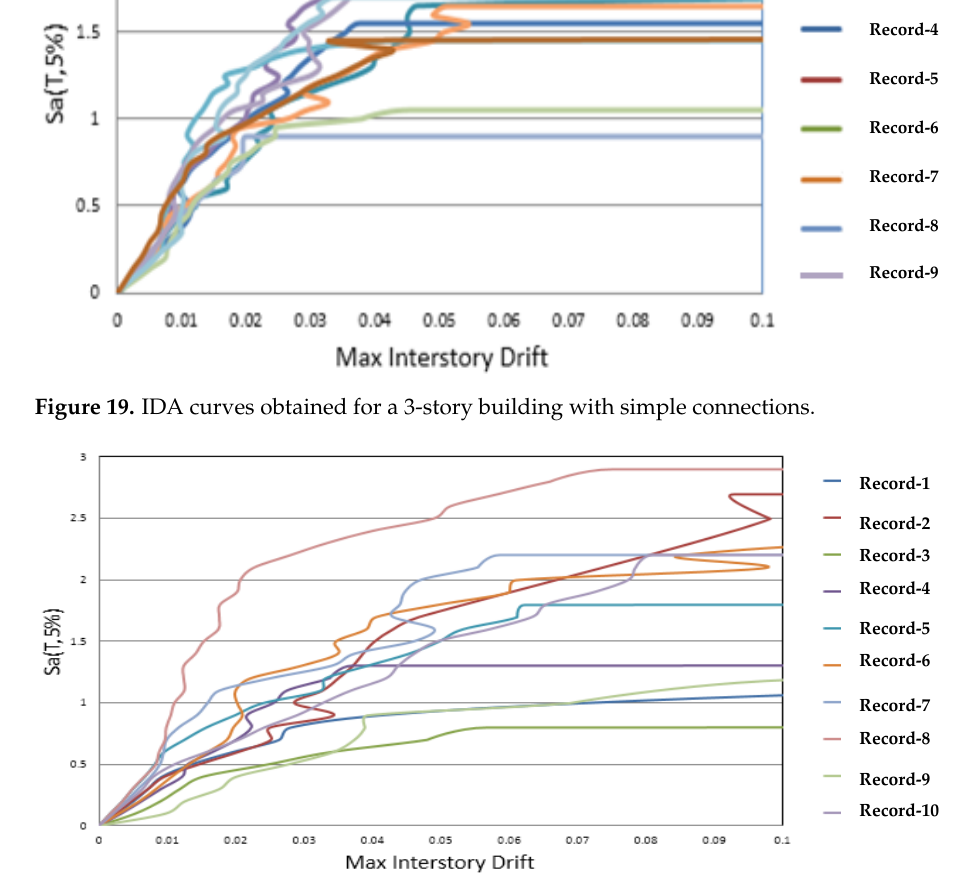
Figure 20. IDA curves obtained for a 3-story building with semi-rigid connections.